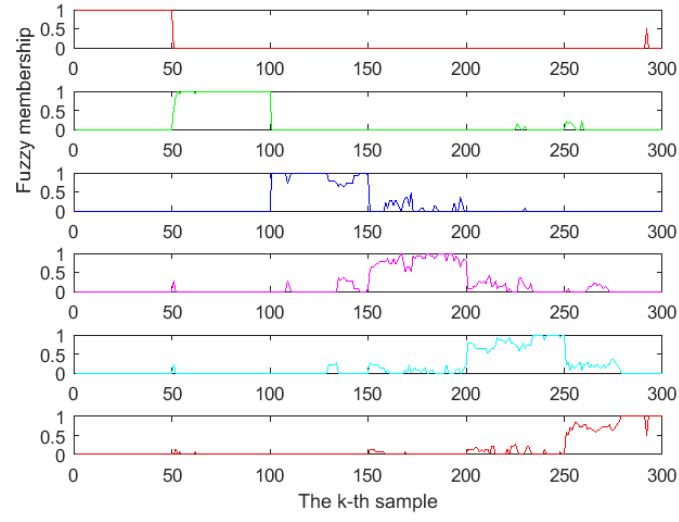
Figure 7. The fuzzy membership values of six Chinese liquor samples.